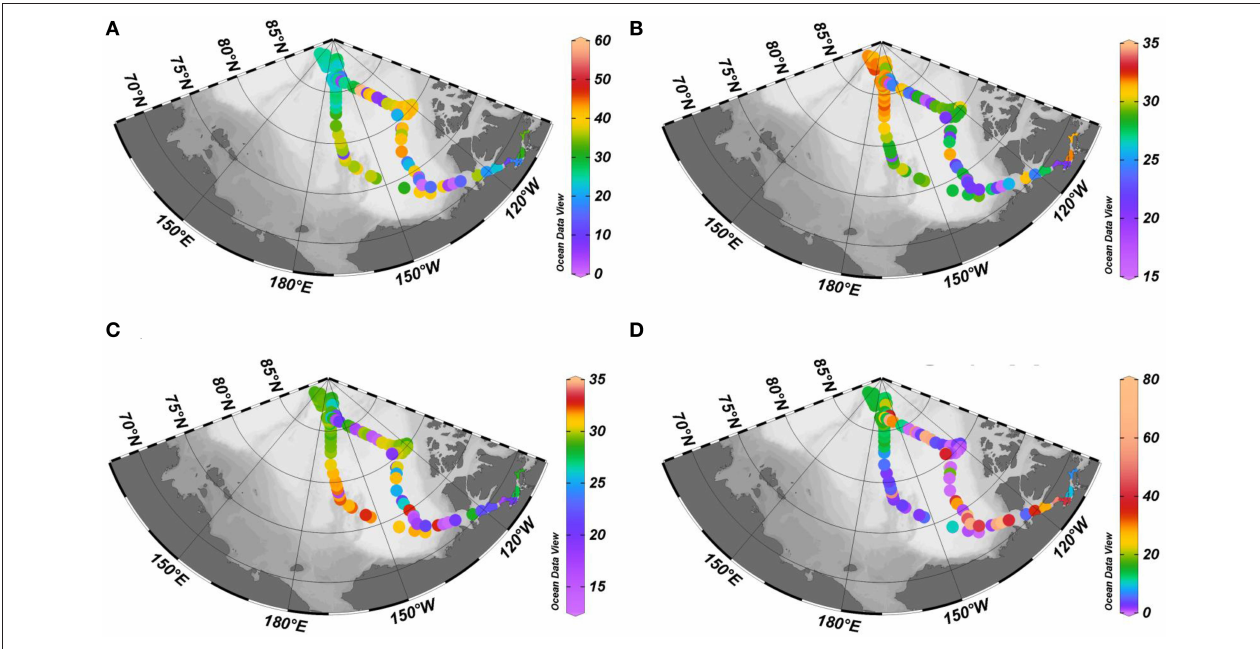
FIGURE 6 | Relative abundance of (A–D) humic-like C1–C4.